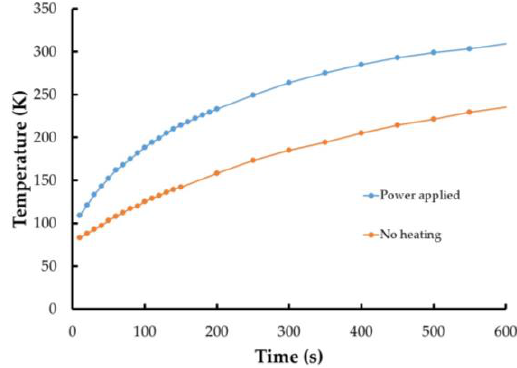
Figure 6. Thermocouple measurements from coupon with CNT heater powered (blue) and unpowered (orange) after immersion in liquid nitrogen.